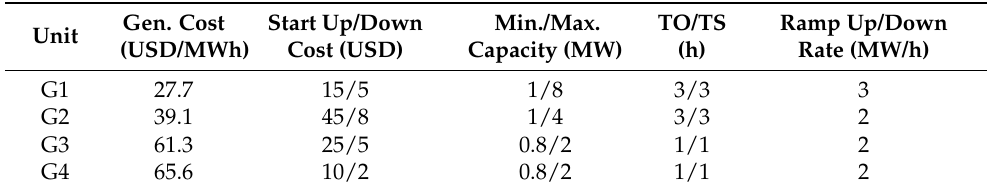
Table 1. Parameters of the controllable generators Gen. Cost Unit